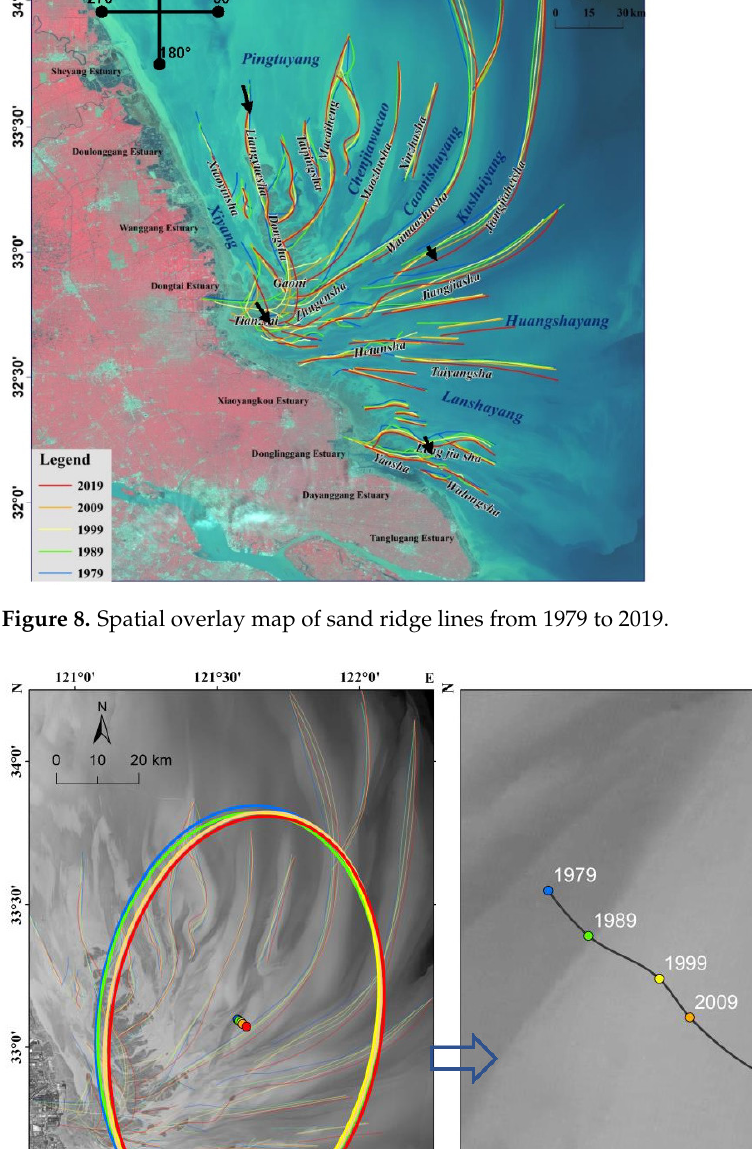
Table 2. Statistical table of morphological parameters of sand ridges.